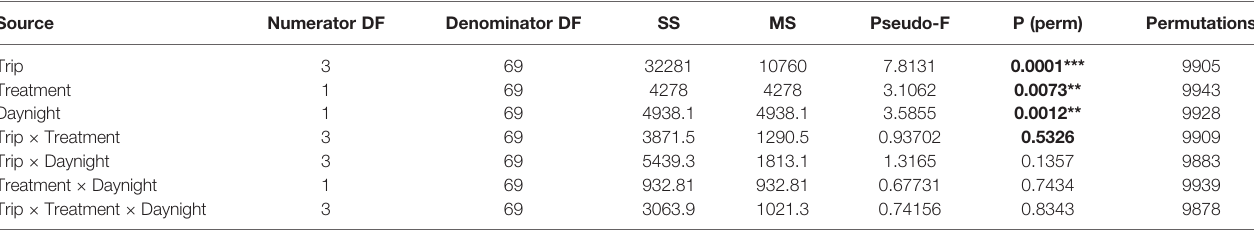
TABLE 6 | Results of permutational multivariate analysis of variance for zooplankton composition. Source